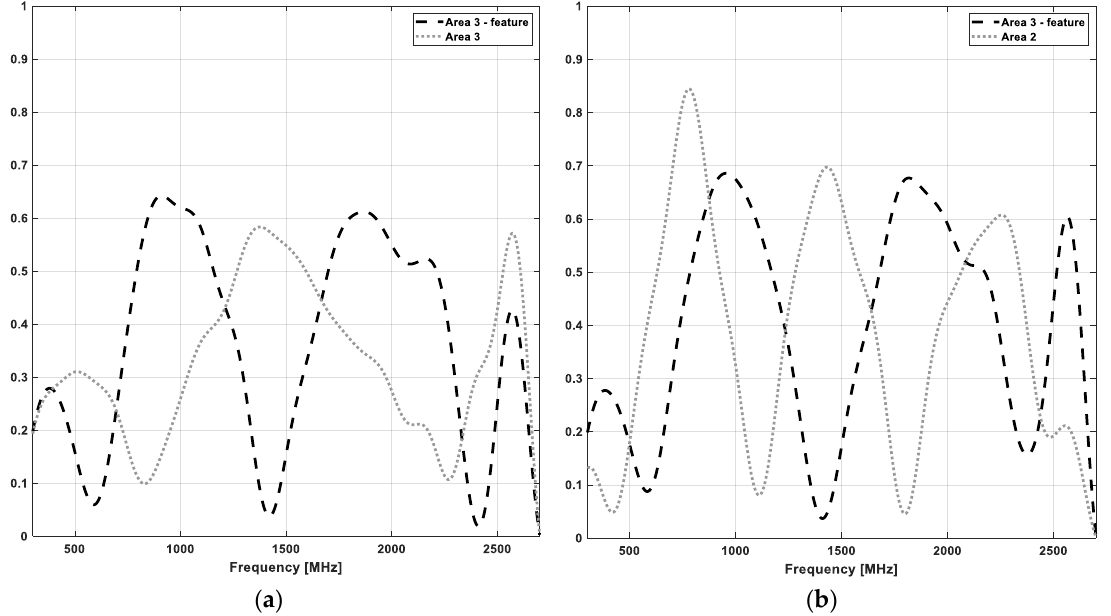
Figure 18. Amplitude variations with frequency for the highlighted feature. ( a ) Comparison with Area 3; ( b ) Comparison with Area 2.